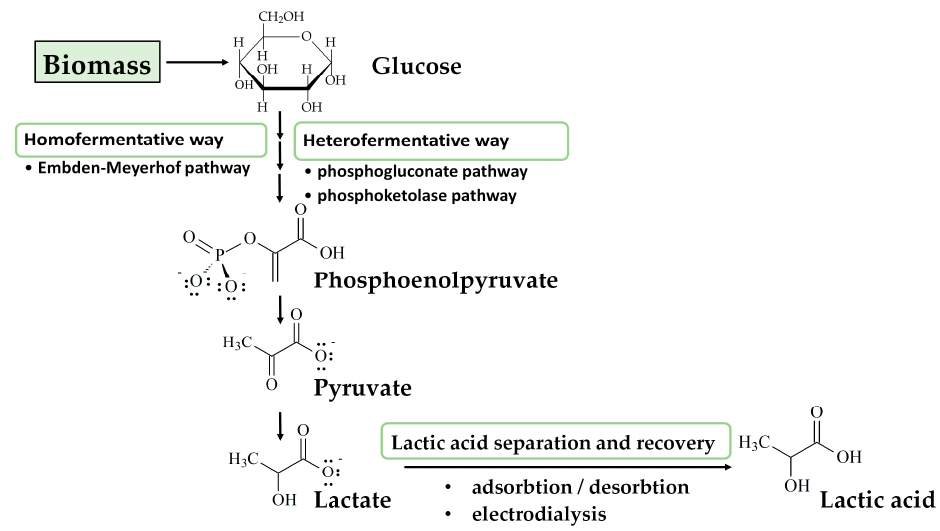
Figure 4. Lactic acid production by LAB fermentation.